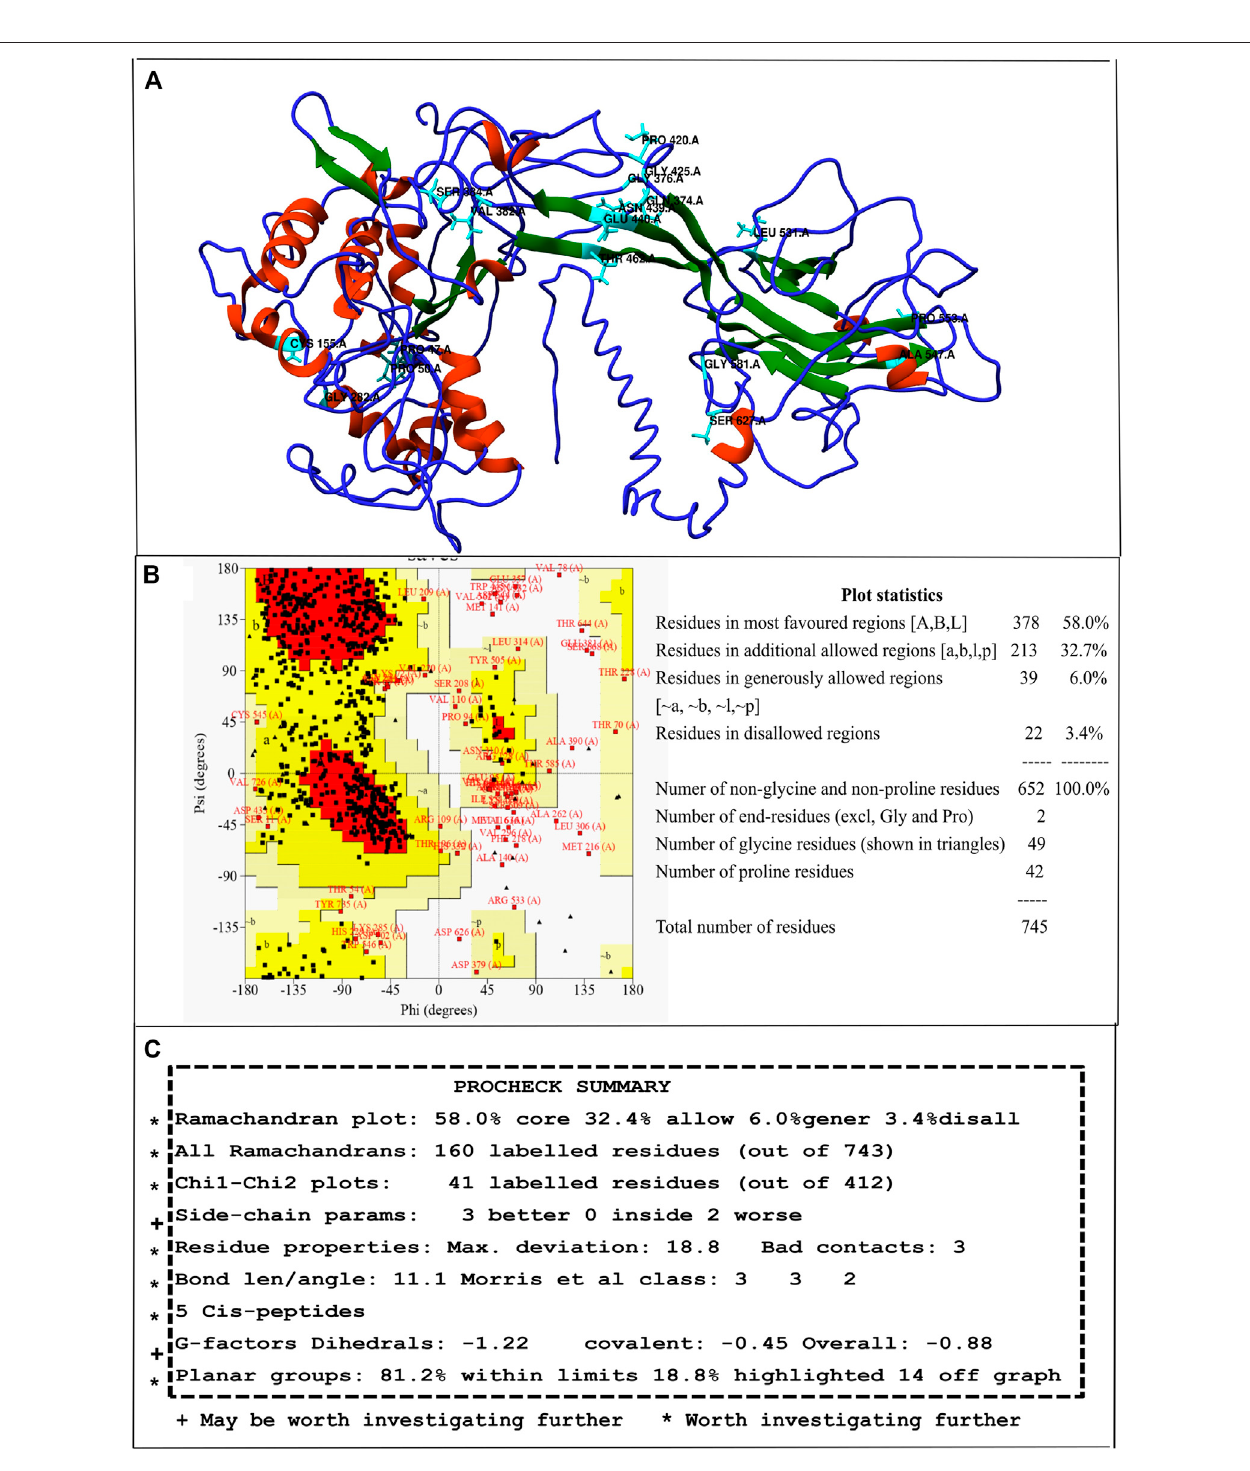
FIGURE 2 | Full-length 3D model of hZP2 generated by I-TASSER. (A) Helix regions are shown in red, strand in blue, and coil in green. The positions of 18 deleterious nsSNPs are highlighted in cyan. (B) Ramachandran plot for the 3D model of hZP2 (C) Screenshot showing the summary of PROCHECK results.